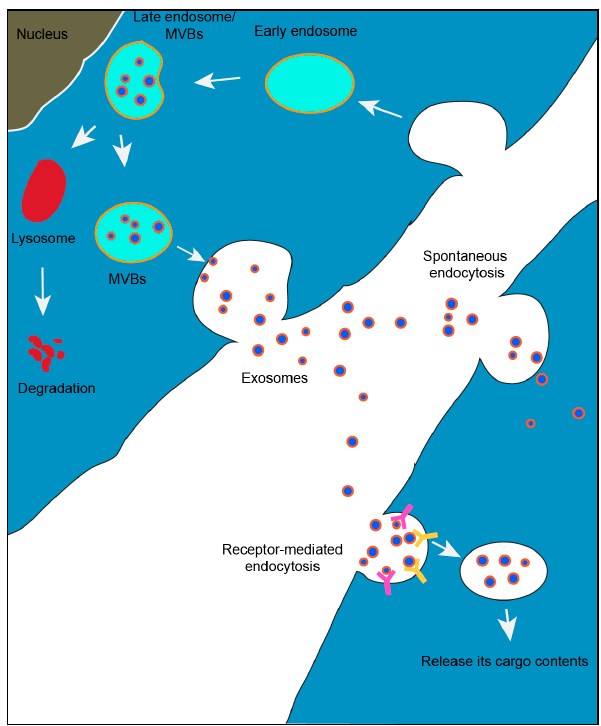
Figure 2. Exosome biogenesis begins with budding into early endosome and further matures into late endosome, collectively known as multivesicular bodies (MVBs). Thus, formed multivesicular bodies fuse with plasma membrane to release exosomes into outer cellular environment to communicate with other cells. The late endosomes fuse with the lysosome to undergo degradation pathway. In recipient cells, exosomes are taken up by receptor-mediated endocytosis process and release their cargo contents.